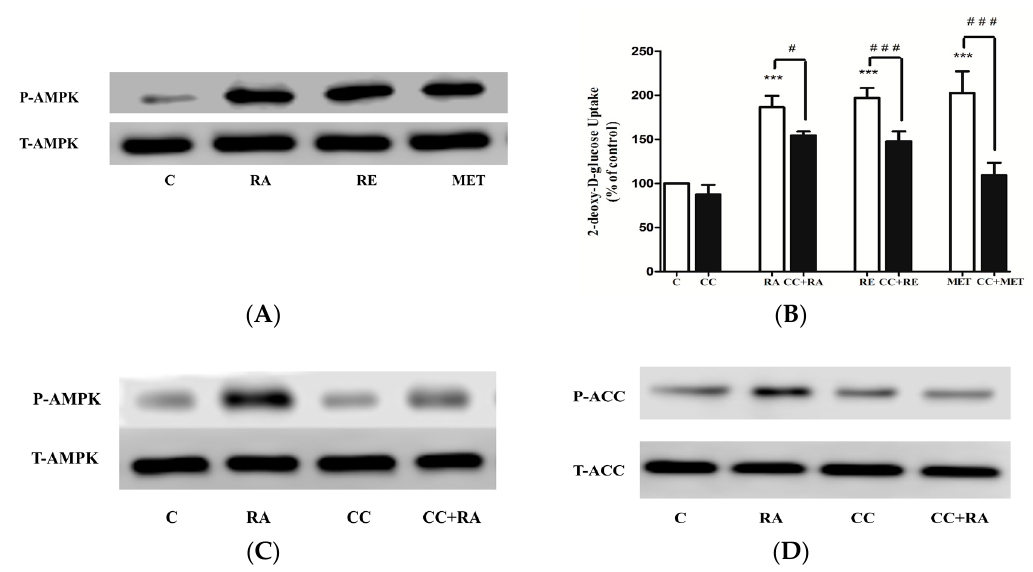
Figure 4. ( A ) Effect of RA on AMPK. L6 myotubes were treated without (control, C) or with 5.0 µ M RA (2 h), 5 µ g/mL of RE (2 h), 2 mM metformin (MET) (2 h). Whole-cell lysates were prepared, resolved by SDS-PAGE and immunoblotted with specific antibodies that recognize phospho-AMPK (Thr 172) (P-AMPK) or total AMPK (T-AMPK). ( B ) Effect of compound C (CC) on rosmarinic acid (RA)-induced glucose uptake. Cells were incubated in the absence or presence of 25 µ M compound C (CC) for 30 min followed by the addition of 5.0 µ M RA, 5 µ g/mL of RE or 2 mM MET and glucose uptake measurements. Results are the mean ± SE of 6–7 independent experiments. *** p < 0.001 vs control. ### p < 0.001 vs treatment in the absence of CC. ( C ) Effect of compound C (CC) on RA-induced AMPK and ( D ) ACC phosphorylation. Whole-cell lysates were immunoblotted for phospho-AMPK (Thr 172) (P-AMPK), total AMPK (T-AMPK) ( C ) or for phospho-ACC (Ser 79) (P-ACC) or total ACC (T-ACC) ( D ).